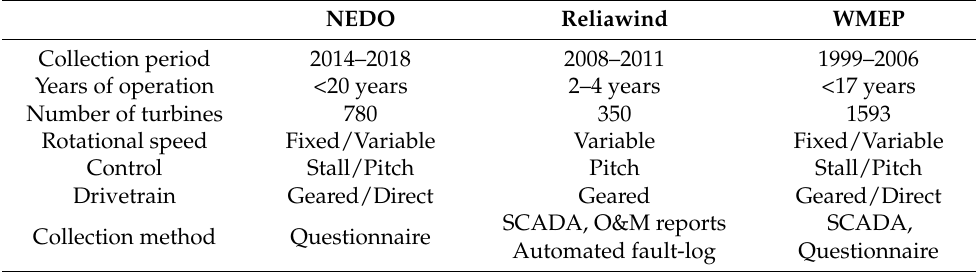
Table 2. Description of characteristics in each database.